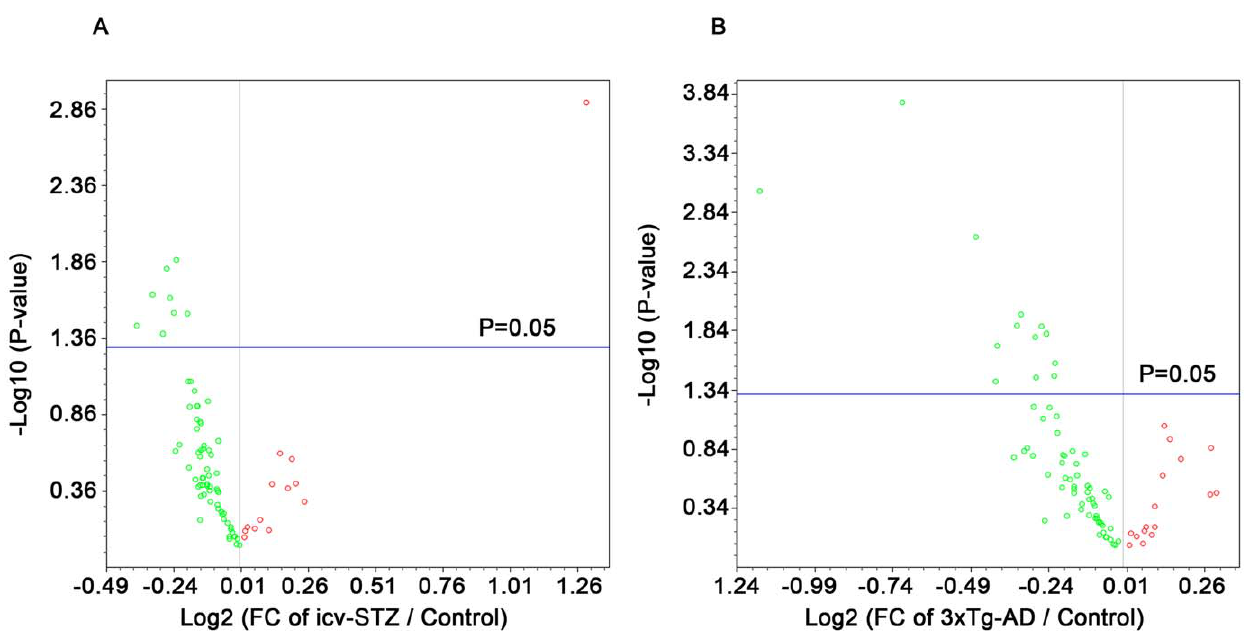
Figure 2. Volcano plots of the gene expression changes in icv-STZ mice and 3xTg-AD mice. Fold changes (FC) in gene expression of icv- STZ mice vs. control mice (A) and 3xTg mice vs. control mice (B). Each dot represents one gene. Green, down-regulated; red, up-regulated.